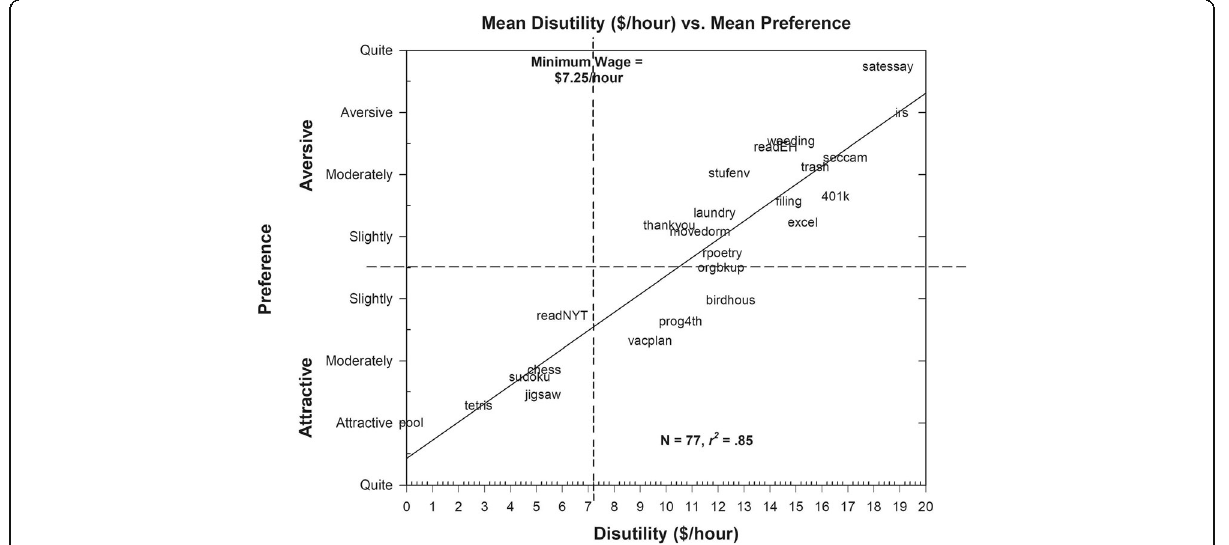
Fig. 3 Mean disutility ($/hour) plotted against mean preference values. Dashed lines indicate boundaries for minimum wage (on the abscissa) and between ratings of attractiveness and aversiveness (on the ordinate). N =77. Linear regression shown with solid line . Tasks are shown as abbreviated labels from Table